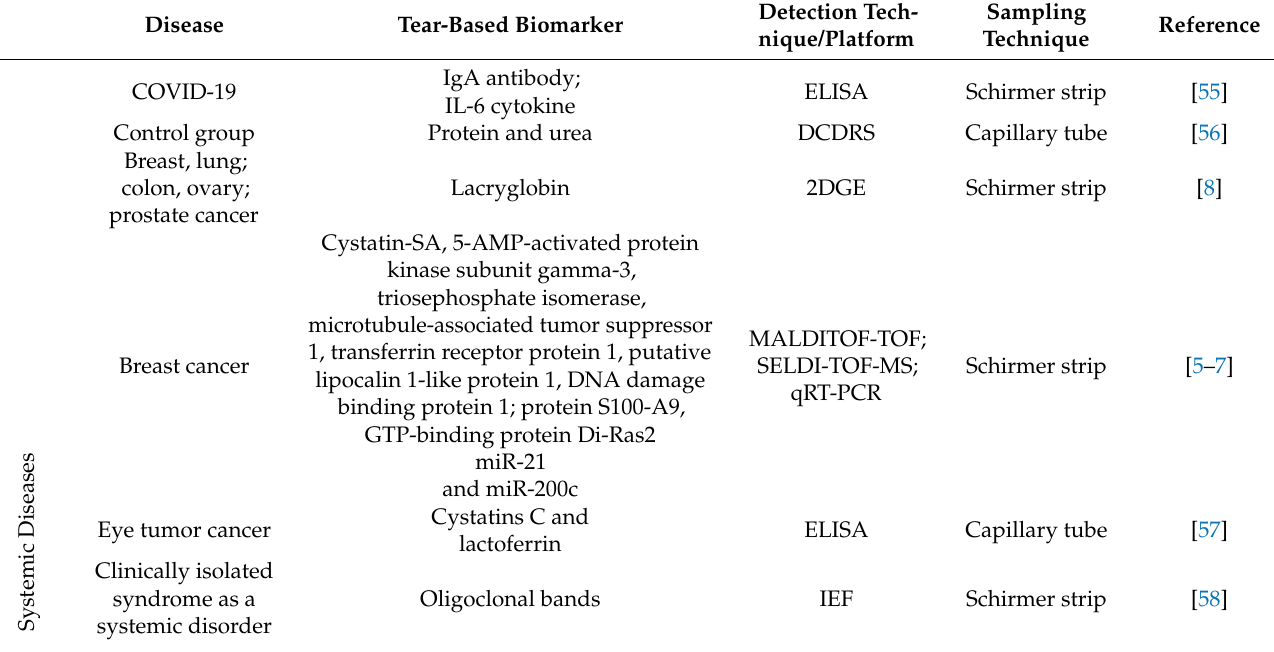
Table 1. Tear-based biomarkers and analysis techniques used in the diagnosis of specific diseases.